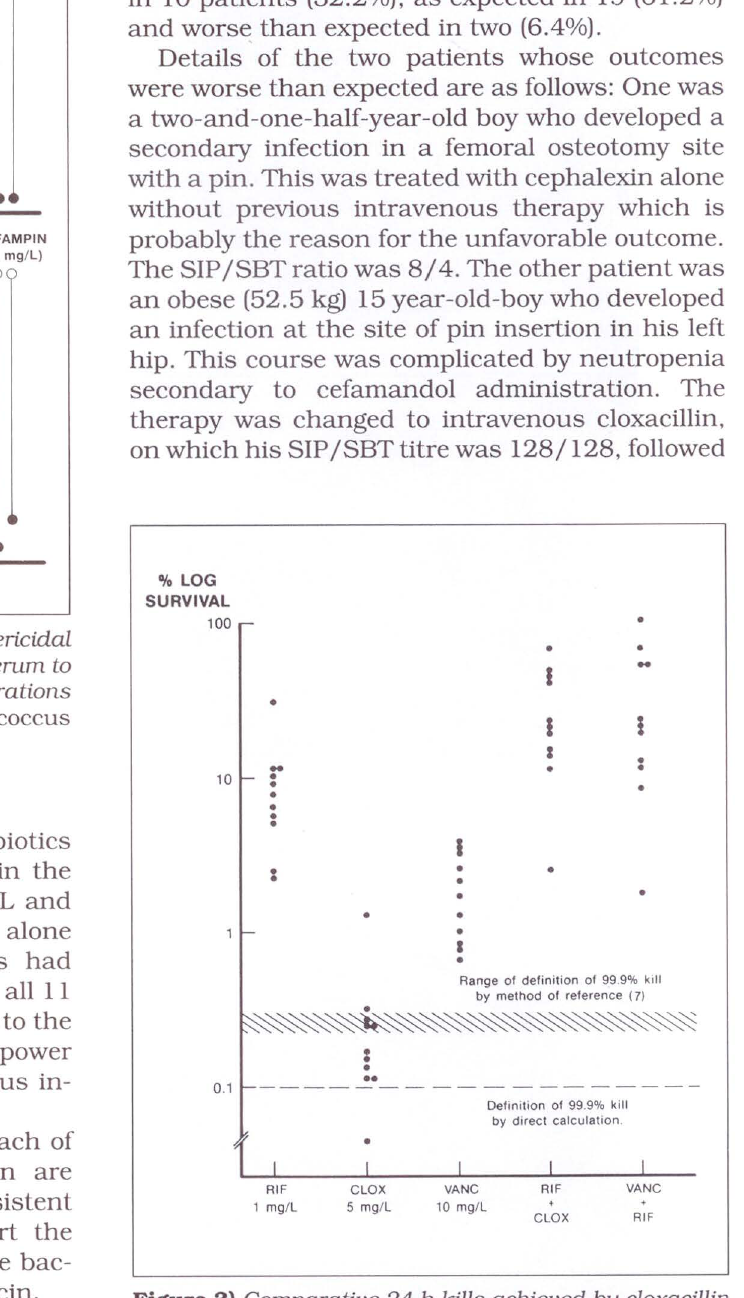
Figure 3) Comparative 24 h kills achieved by cloxacillin and vancomycin alone and in combination with rifampin. The upper shaded horizontal line indicates the range for a 99.9% kill by the method of Pearson et al (7) and the lower line is derived from direct calculation of the ex pected number of colonies. Eleven strains of Staphylococcus au reus were exposed for 24 h to cloxacil lin (CWX) (5 mgiL), vancomycin (VANC) (10 mgiL}, and rifampin (RIF) ( 1 mg I L) alone and in combination as shown. Starting inoculum was adjusted to approximately 1 0 6 I mL and